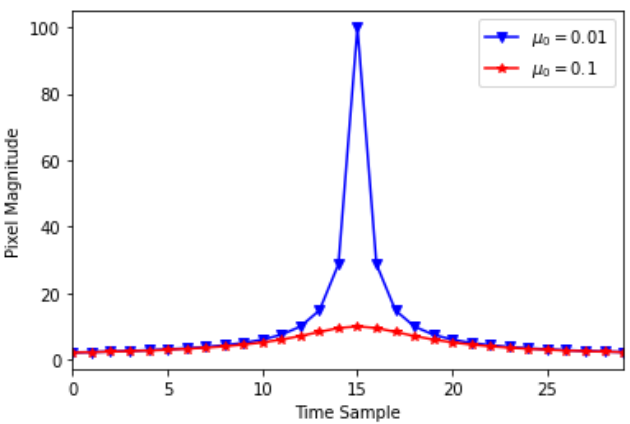
Figure 5. Magnification curve for µ 0 = 0.1 and µ 0 =